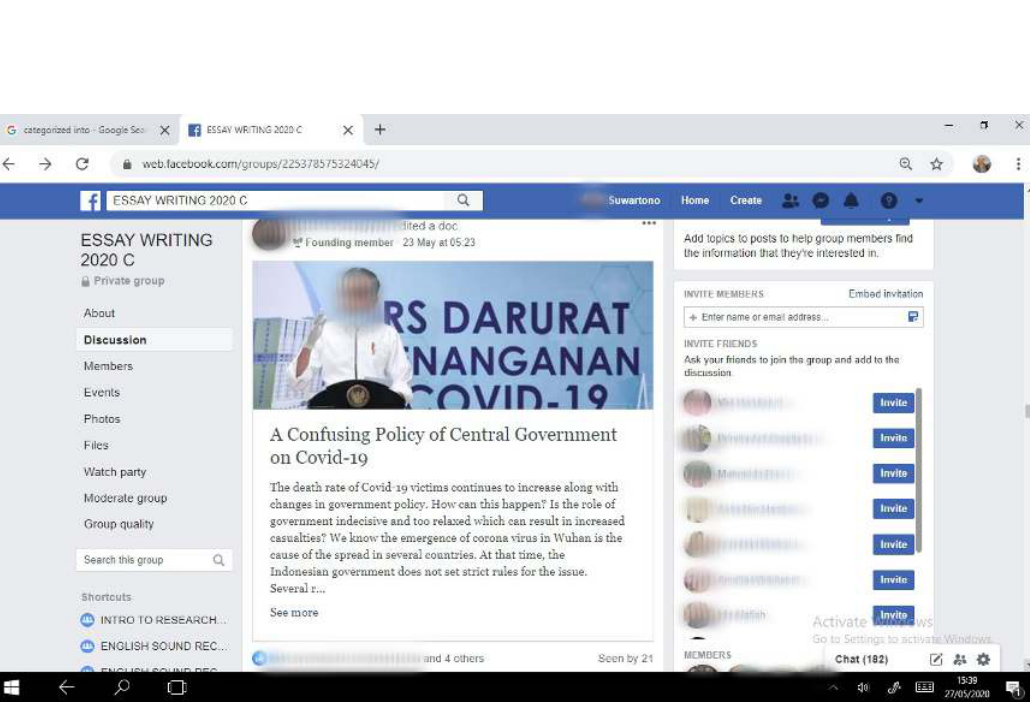
Figure 4. A sample student’s essay in ‘Create Doc’ Professional